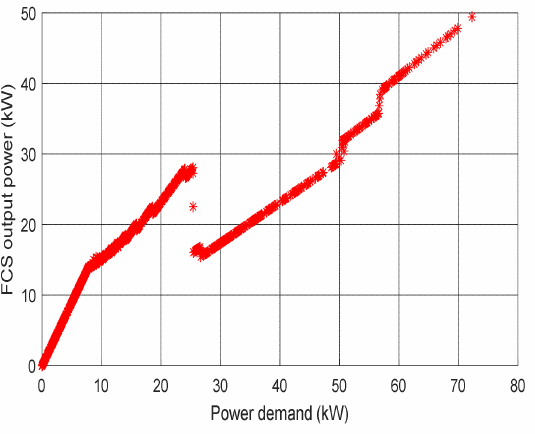
Figure 11. Output power of the fuel cell system and vehicle power demand on the WLTC drive